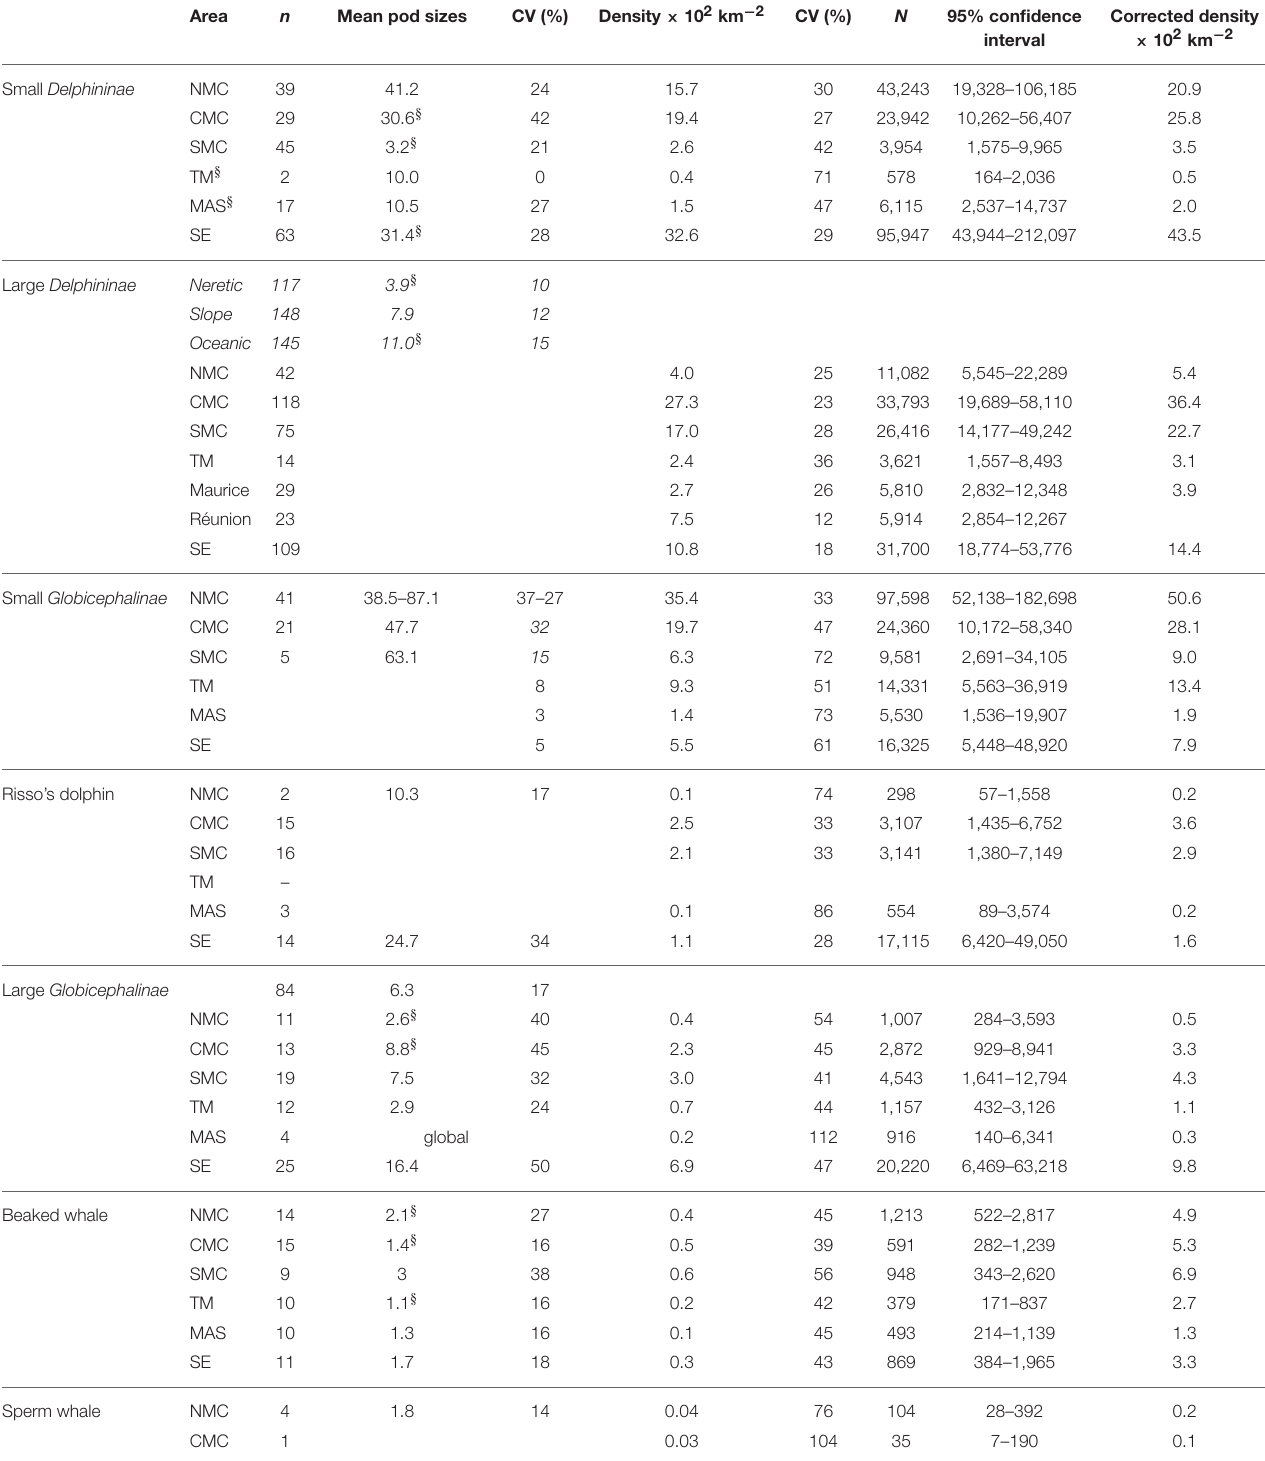
TABLE 3 | Results obtained for cetaceans: sightings number (n) mean or regressed (marked with §) pod size, uncorrected densities with corresponding relative abundance (N) estimated per taxonomic group and survey blocks and corrected density considering different availability bias factor per species. Area